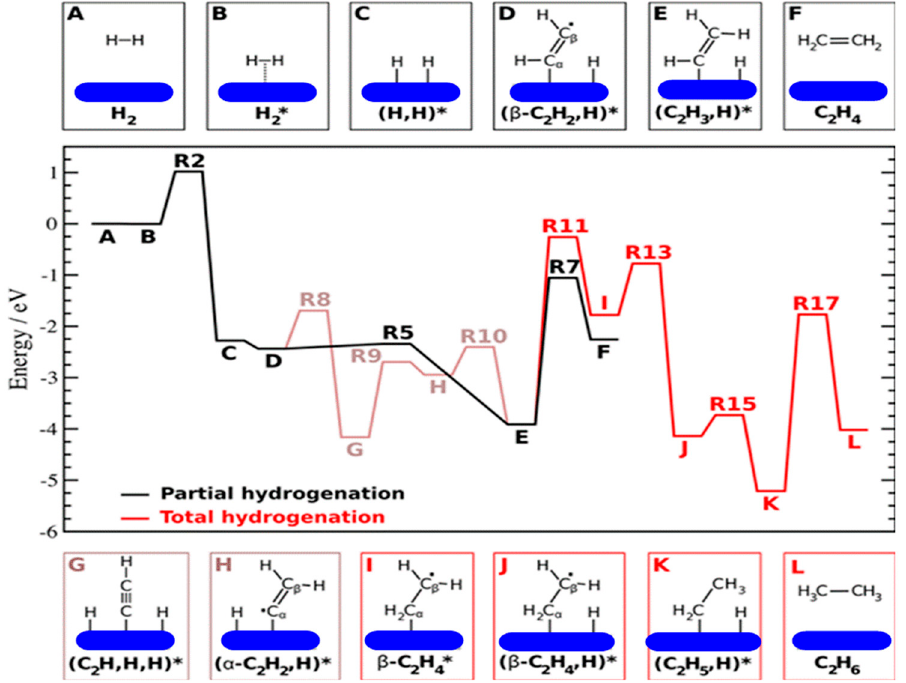
Figure 10. Reaction energy diagram for total hydrogenation of acetylene on CeO 2 (111) catalyst. Energies are computed as a reference to the energy of H 2 and C 2 H 2 in the gas phase and the clean CeO 2 (111) slab. Black line shows the routes of partial hydrogenation of acetylene to ethylene through R5, light brown displays the partial hydrogenation via dissociative acetylene adsorption, and red line represents the full hydrogenation to C 2 H 6 . The asterisk denotes a clean CeO 2 (111) surface. Reactants, intermediates, and products that are followed by an asterisk correspond to the adsorbed species. The asterisk in reactants, products, and intermediates correspond to adsorbed moieties [125].